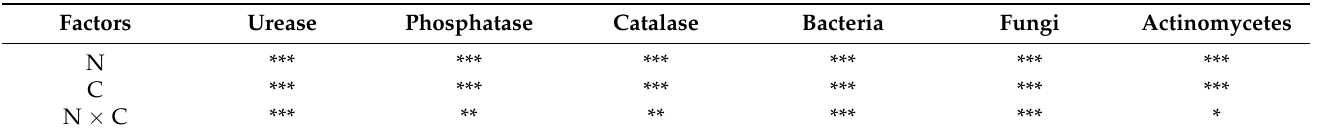
Table 1. Output of two-way ANOVA of urease, phosphatase, catalase, bacteria, fungi, and actinomycetes as affected by N (N1, N2, N3, and N4) and biochar (C0, C30, C50, and C70).